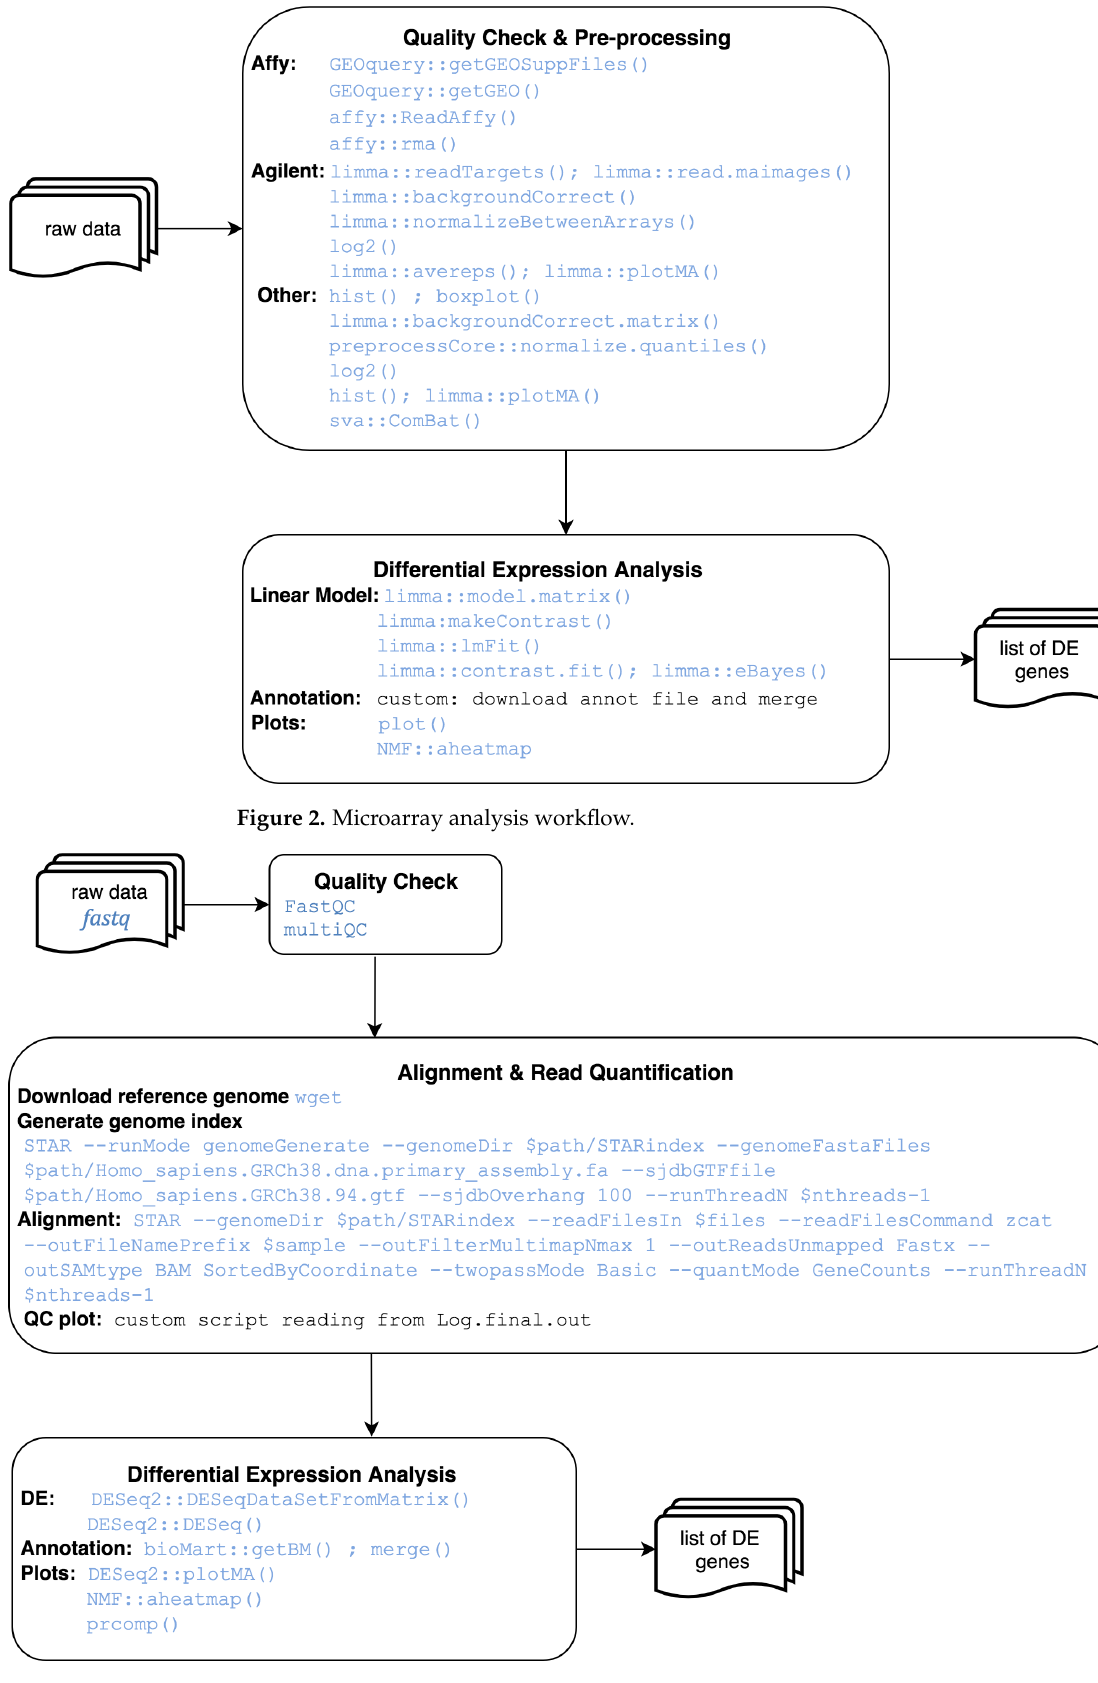
Figure 3. RNA-Seq analysis